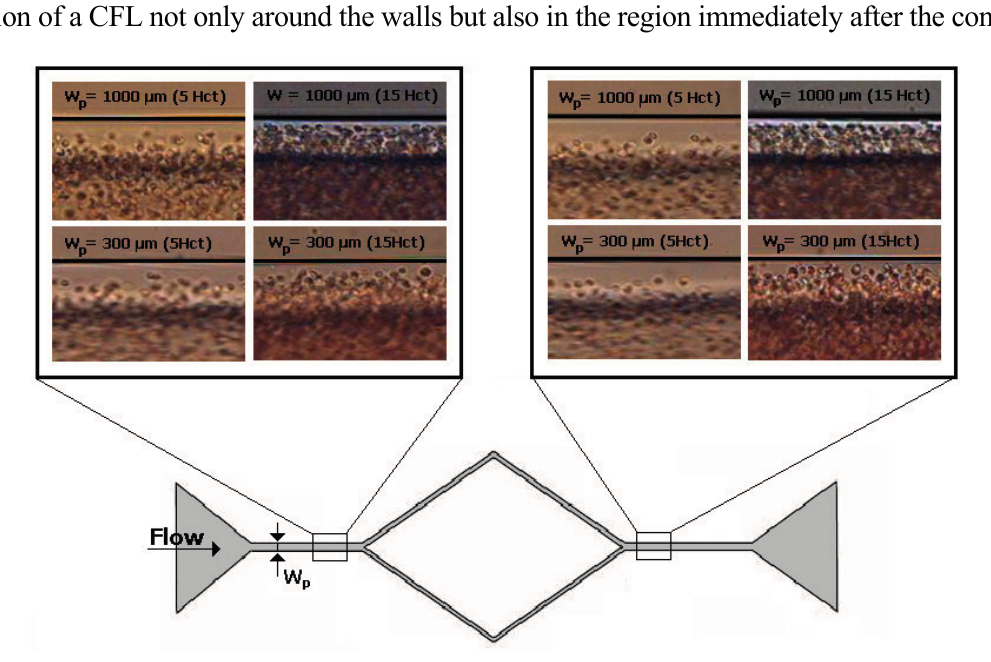
Figure 9. Visualization of in vitro blood with 5% Hct and 15% Hct flowing in a microchannel geometry with a diverging and converging bifurcation for a width of the parent channel (Wp) of 300 and 1000 μ m. The flow rate was 10 μ